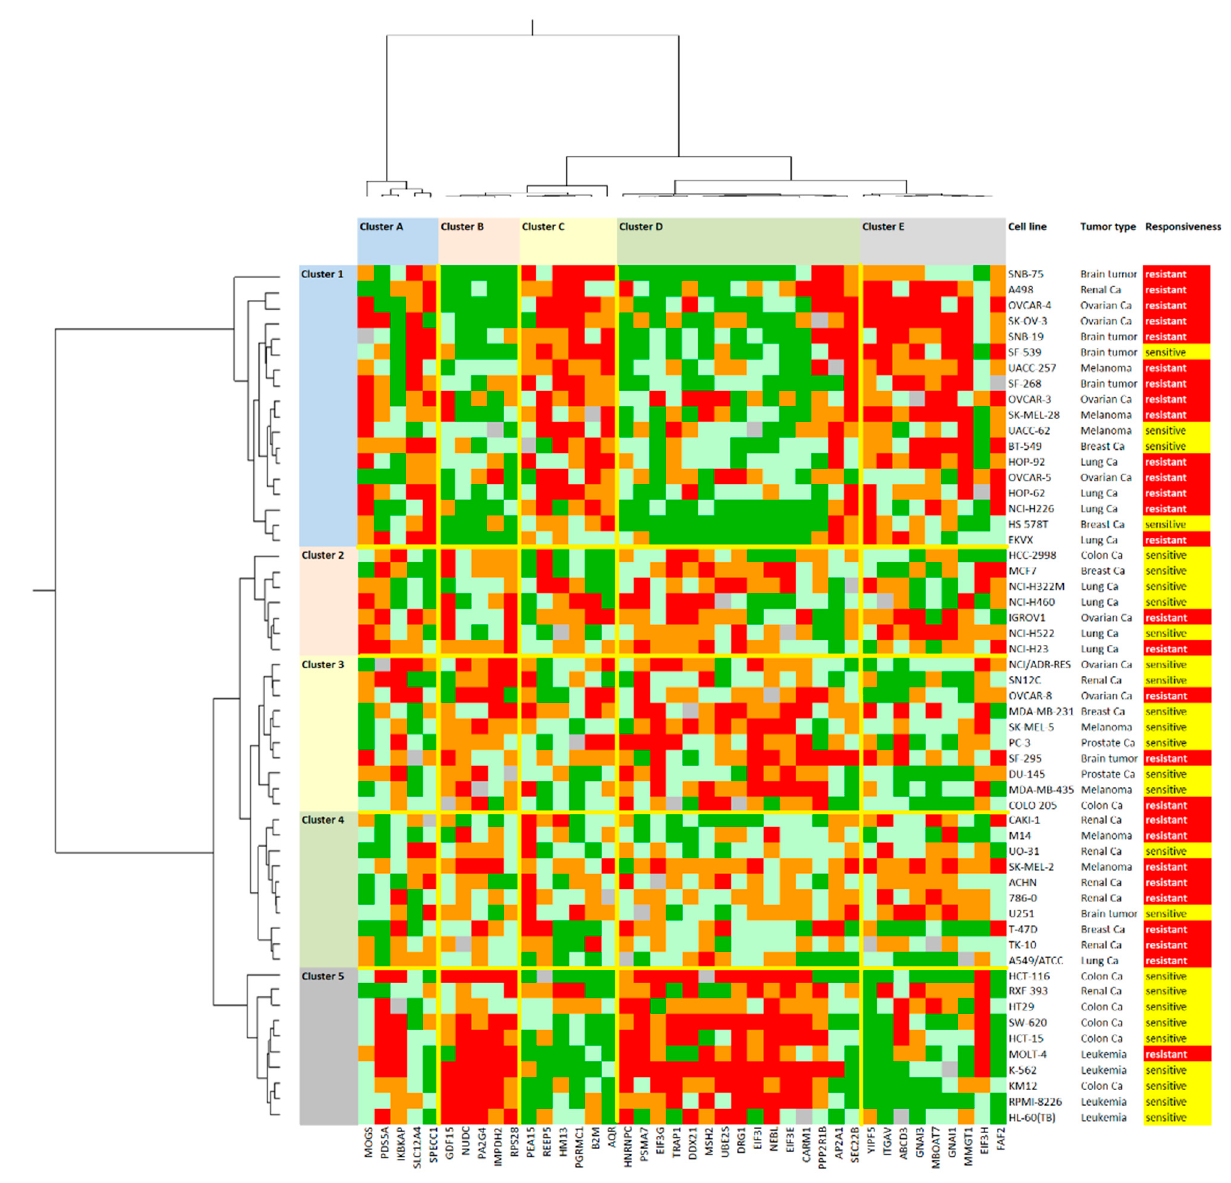
Figure 8. Heat map and agglomrative cluster analyses of the protein expression in the response of 55 tumor cell lines to gedunin (log 10 IC 50 ). The proteins are labeled as numbers at the top of the heatmap. The proteins assigned to each number are given in Supplementary Table S2. The cell lines, their tumor origins, and their sensitivity/resistance to gedunin are shown at the right side of the heat map. Cell lines with individual log 10 IC 50 values smaller than the median value of all of the 55 cell lines tested ( − 5.125 M) were defined as being sensitive, while all of the others with log 10 IC 50 values above the median were defined as being resistant to gedunin. The cluster analysis (Ward method) separated the proteins into five clusters (clusters A-E) and the cell lines also into five clusters (clusters 1–5). The cell lines were clustered according to their degrees of relatedness to each other on the basis of their protein expression included in the analysis. Color code: red, 0–25% quartile; orange, 26–50% quartile; grey, median value; light green, 50–75% quartile; dark green, 76–100% quartile.